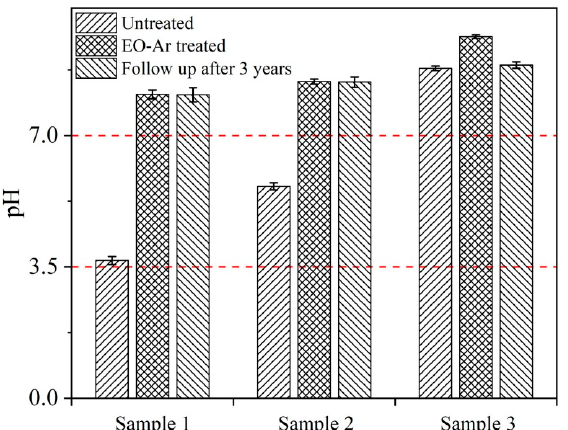
Figure 1. Comparison of pH values for paper samples (sample 1 is groundwood printing papers; sample 2 is ingrain paper; sample 3 is xuan paper) treated and untreated with EO-Ar.